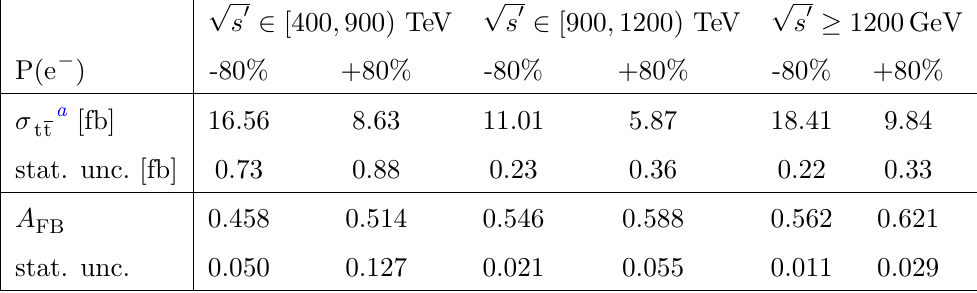
p Table 12. Results for radiative events at s = 1 : 4 TeV with an integrated luminosity of 2 : 0 ab (cid:0) 1 and 0 : 5 ab (cid:0) 1 for P (e (cid:0) ) = -80% and P (e (cid:0) ) = +80%, respectively. Values are shown from three p s 0 below the nominal collision intervals of